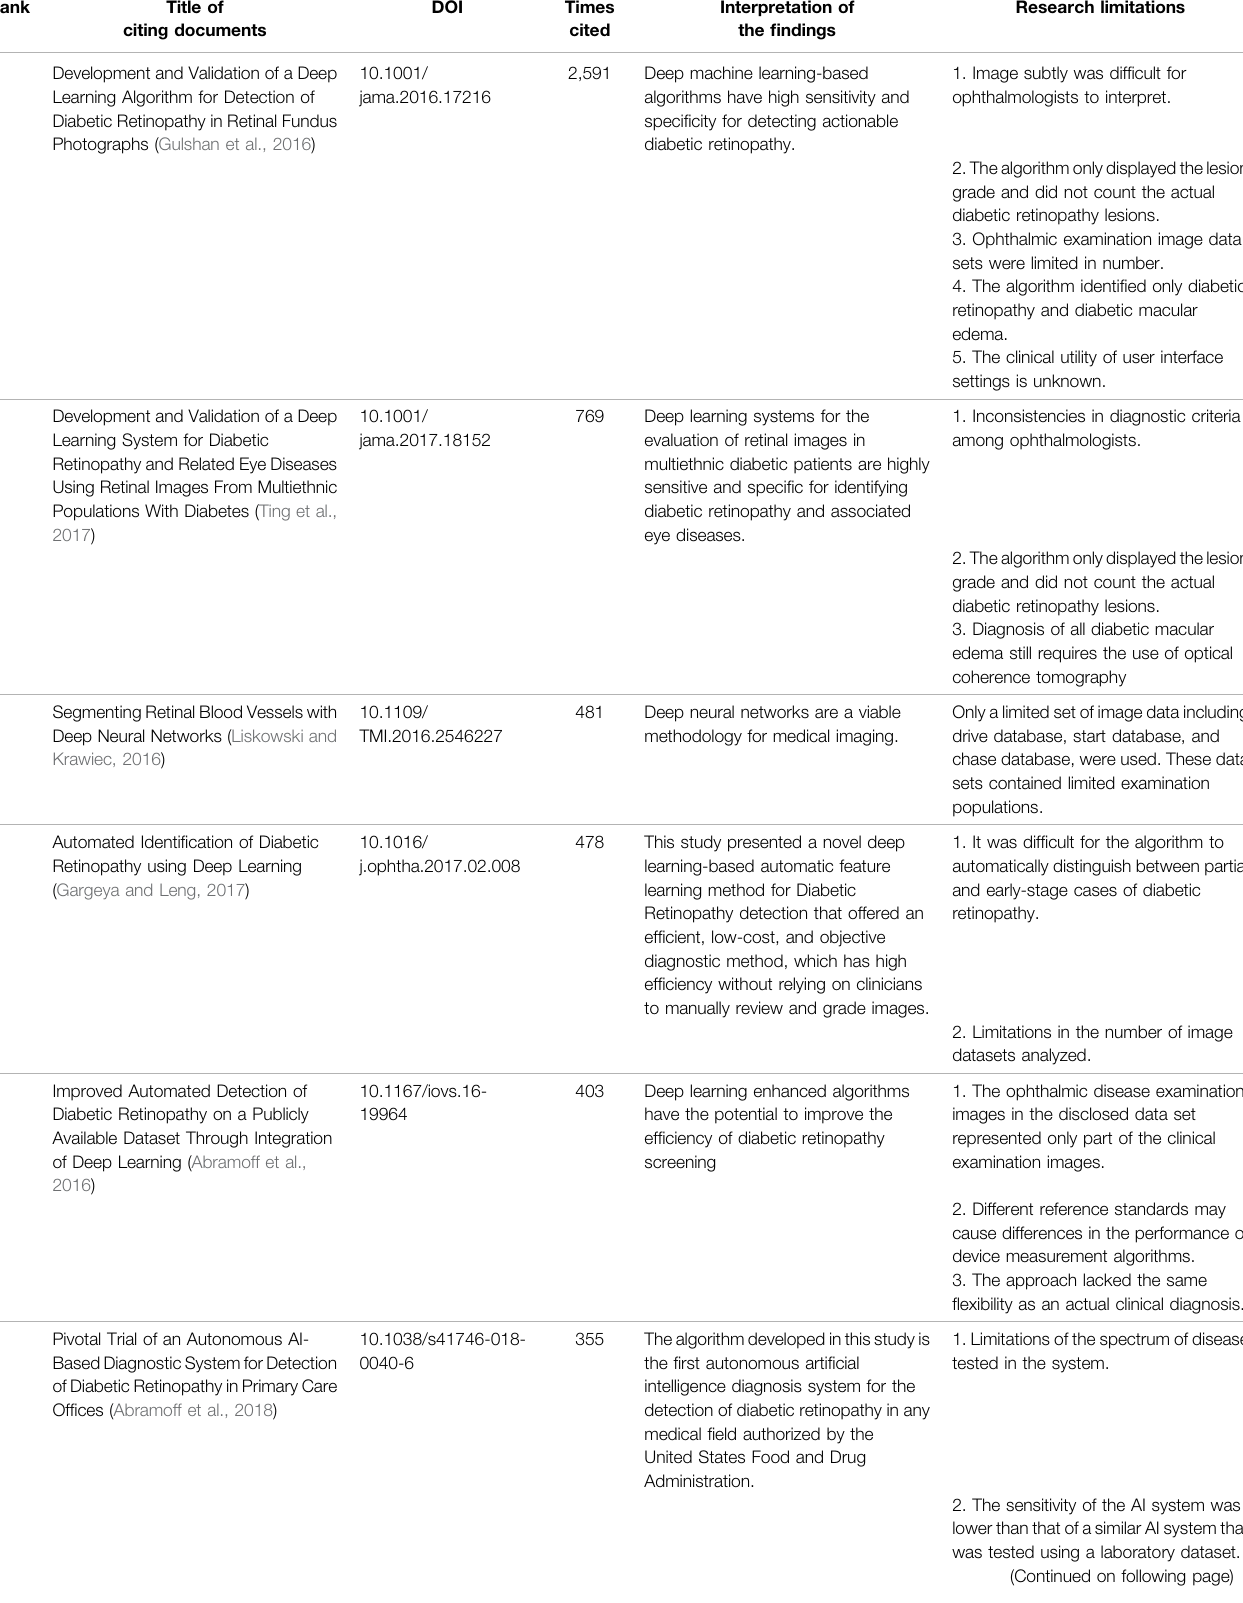
TABLE 5 | Top 10 citing articles on the application of the use of AI in the diagnosis of ophthalmic diseases from 2012 to